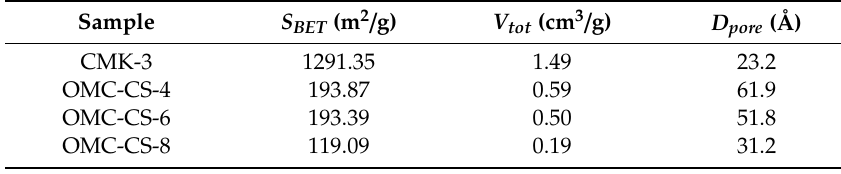
Table 1. Comparison data from adsorption isotherms.